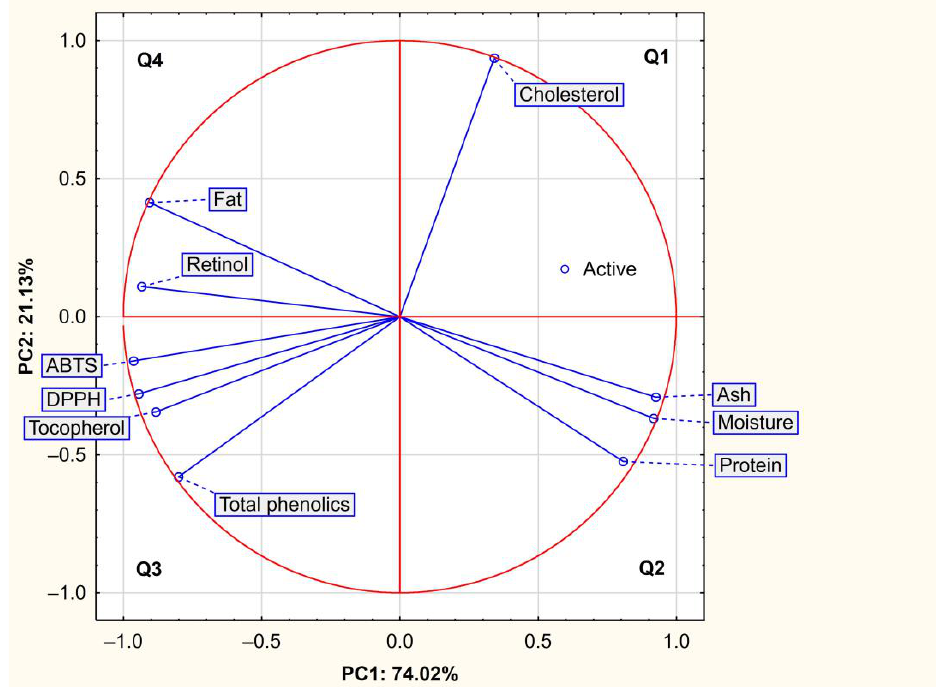
Figure 1. Projection of variables in a two-factor plane (PC1 × PC2).